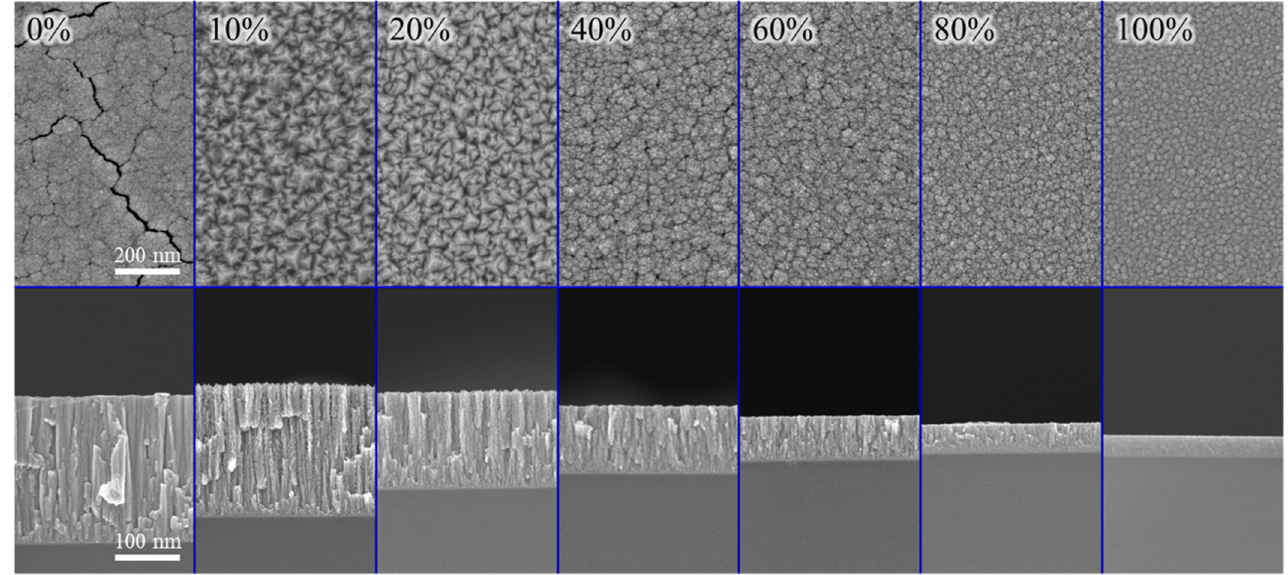
Figure 4. SEM images of (CrHfNbTaTiVZr)N coatings deposited at various R N .